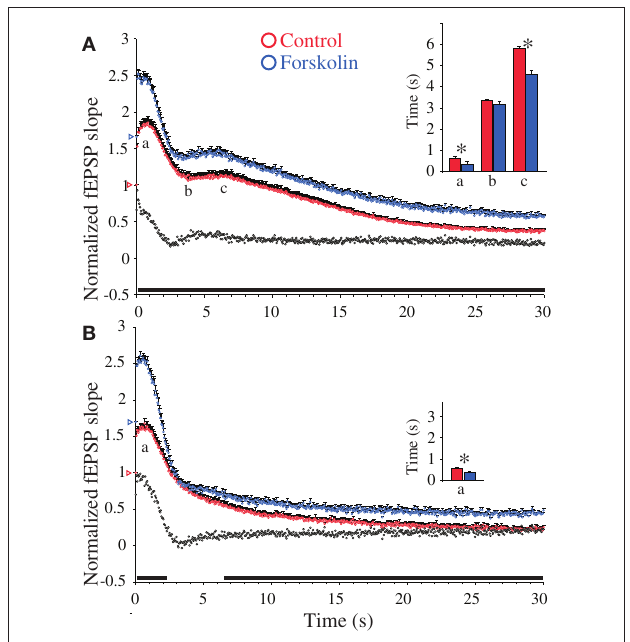
Figure 2 | Forskolin-induced synaptic enhancements during 20 Hz stimulation in hippocampal excitatory CA3-to-CA1 synapses. (A) Normalized fEPSP slope measurements from CA3-to-CA1 synapses during 20 Hz stimulation in slices ( n = 17) from WT mice treated with forskolin (50 µ M, blue symbols) and in experiments without forskolin ( n = 22, red symbols). Vertical bars indicate S.E.M. Subtractions of the values without forskolin from those obtained with forskolin are represented by the black, open symbols. The black horizontal bar along the abscissa indicates p < 0.05 when comparing the two situations. Colored open triangles on the ordinate point to the starting values for the different conditions. a Indicates time point of the maximum magnitude of the initial frequency facilitation; b time to the transition point between the initial frequency facilitation and the DRE; c time needed to reach the peak of the DRE. The average measurements from individual experiments are shown by inset histogram with corresponding colored vertical bars. Vertical bars indicate S.E.M. * p < 0.05 when compared to the control situation. (B) As in (A) but the slice experiments are from DKO mice treated with forskolin (50 µ M, blue symbols) ( n = 18) compared to experiments without the compound ( n = 18, red